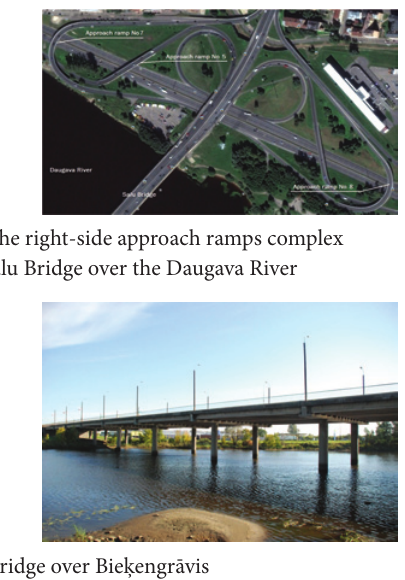
fig. 4. Bridge over Bieķengrāvis